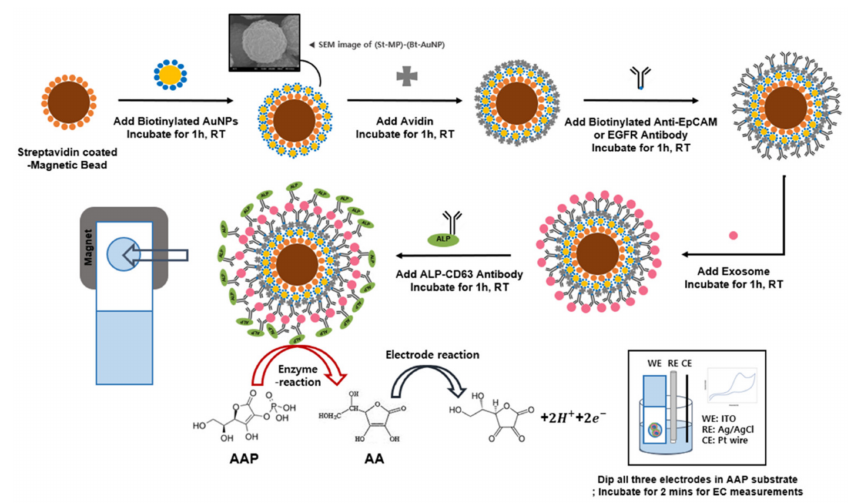
Figure 1. Schematics for AuNP-coated MB complex (AMB) preparation and electrochemical im- munoassay on